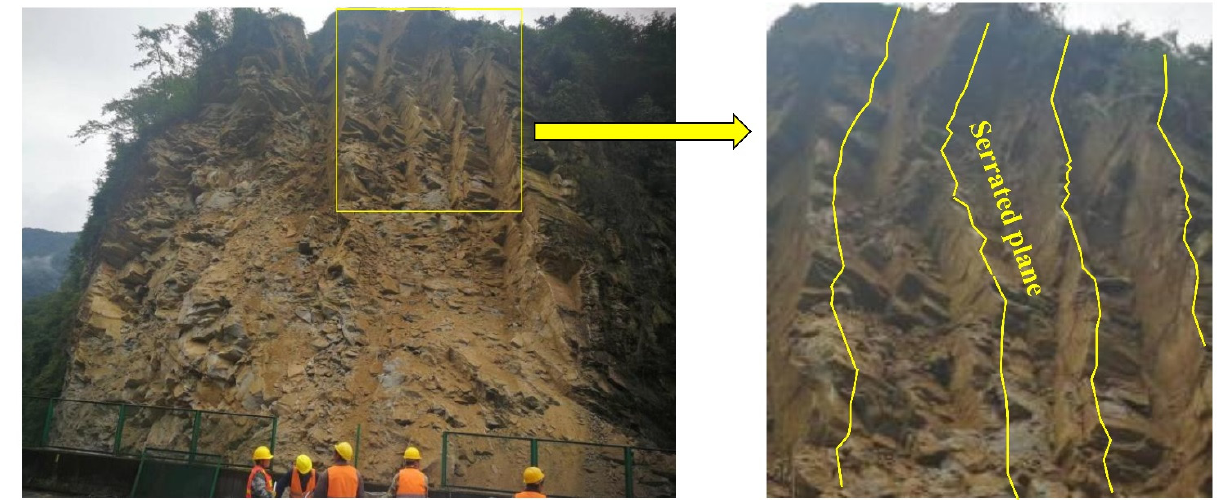
Figure 1. The distribution of one serrated structural plane of a slope.